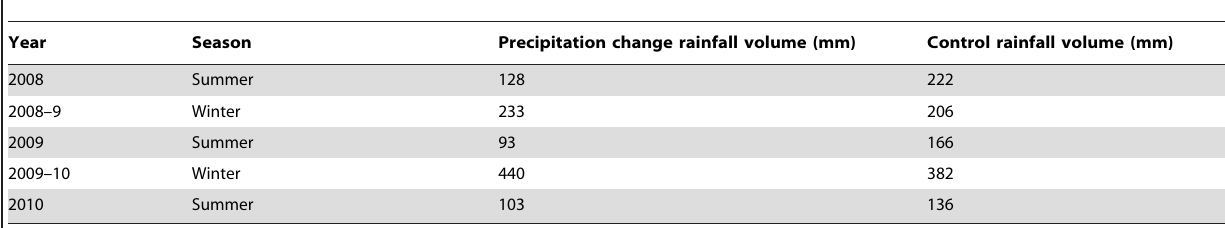
Table 2. Total seasonal rainfall inputs throughout the